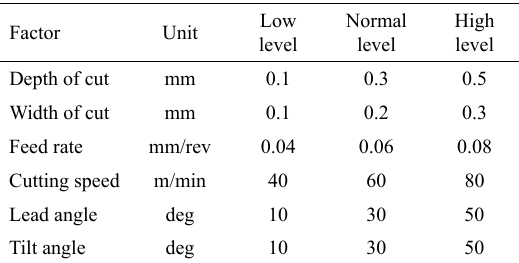
Table 2. Cutting parameters, spindle angles and their levels